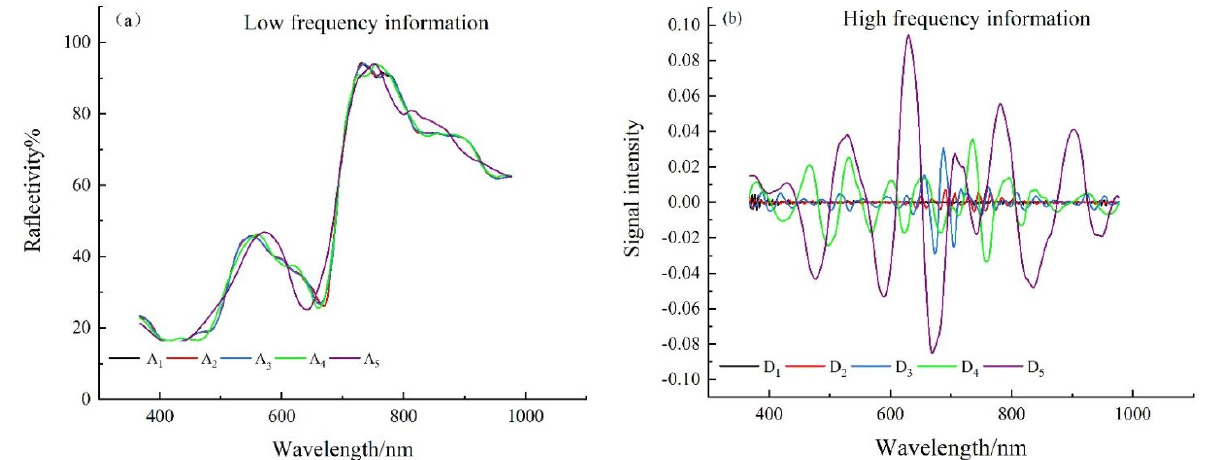
Figure 4. ( a ) Db 5 wavelet analysis-low frequency information graph ( b ) Db 5 wavelet analysis-high frequency information graph.